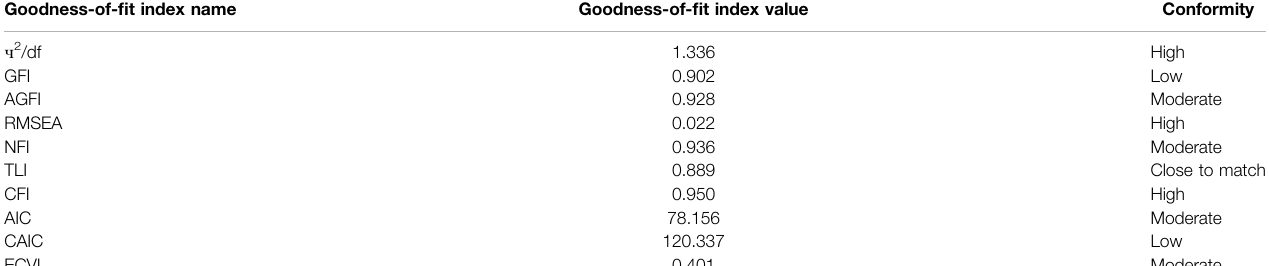
TABLE 6 | List of goodness-of- fi t indices.